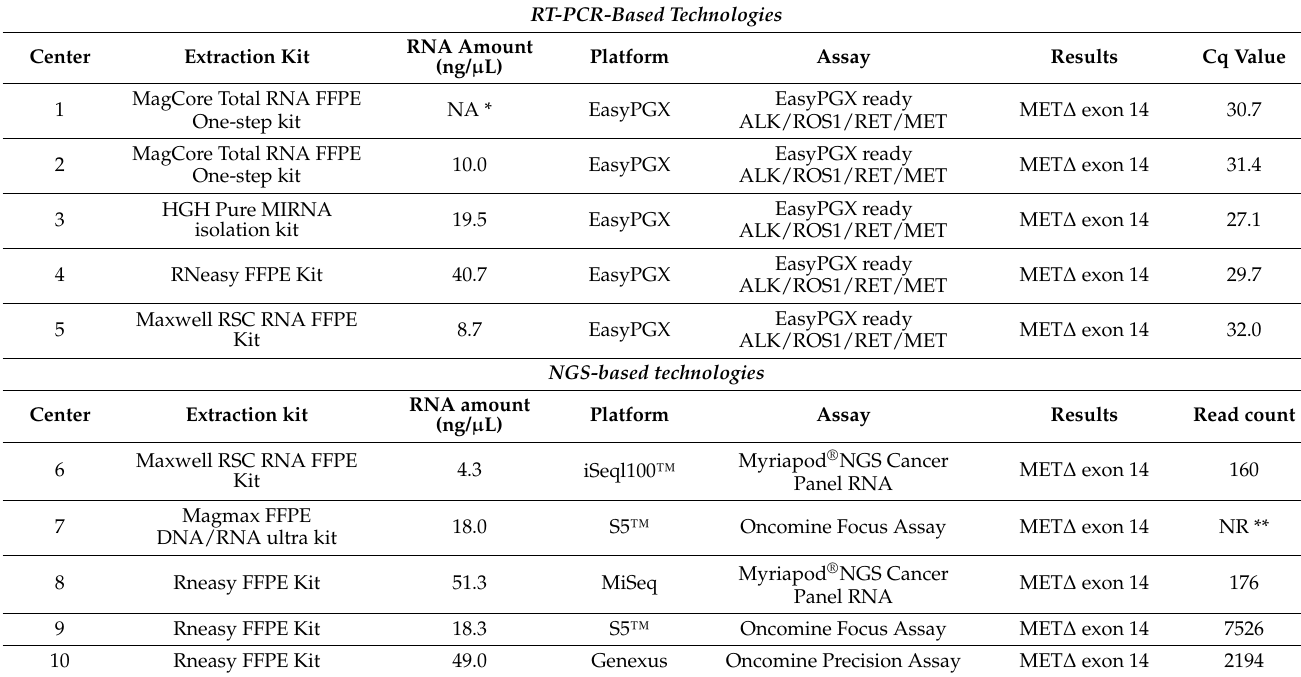
Table 1. RNA-based analysis on reference standard